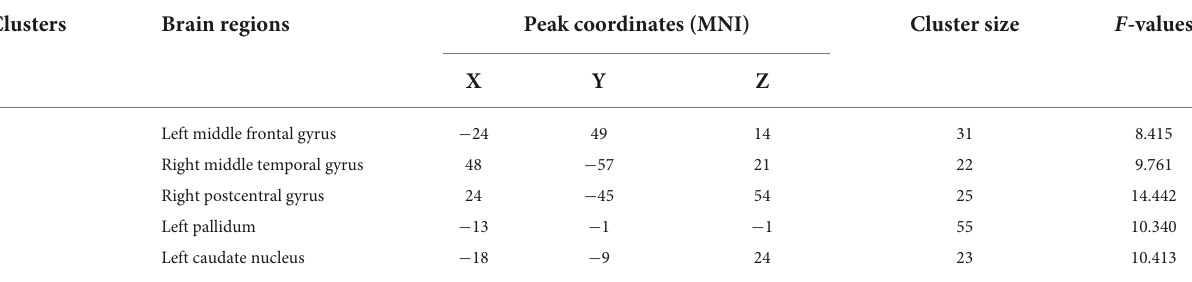
TABLE 2 Brain areas with different ALFF signals for four groups. Clusters Brain regions Peak coordinates